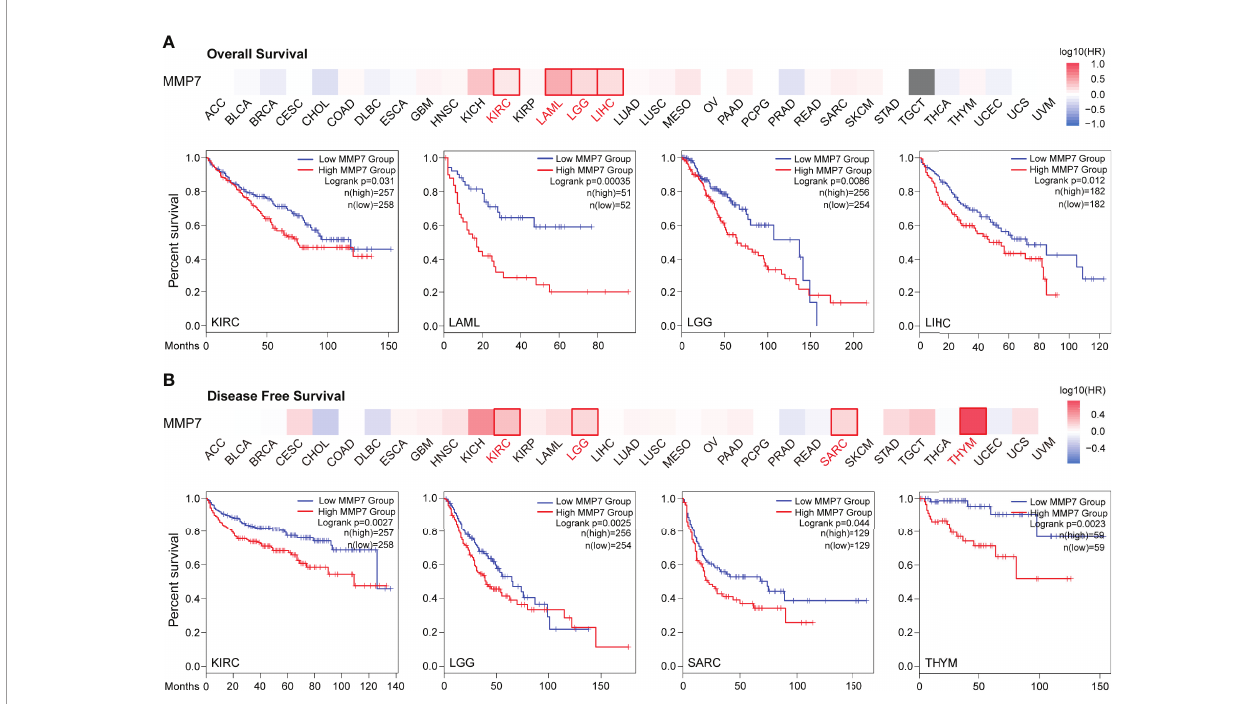
FIGURE 3 | Survival analysis of MMP7 in different TCGA cancers (GEPIA2). The heatmap and Kaplan – Meier curve of overall survival (OS) (A) and disease-free survival (DFS) (B) shows that high expression of MMP7 indicates poor prognosis in KIRC, LAML, LGG, liver hepatocellular carcinoma (LIHC), KIRC, LGG, SARC, and